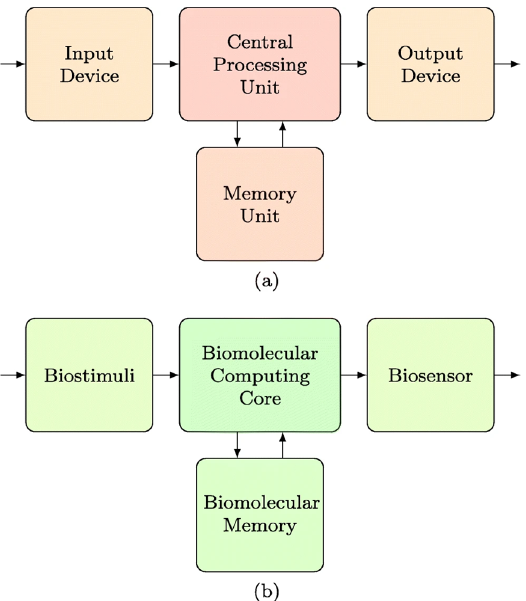
Figure 18. A standard architecture for a computer design ( a ) and a proposed biomolecular computing structure ( b ) (reprinted with permission from [155]).